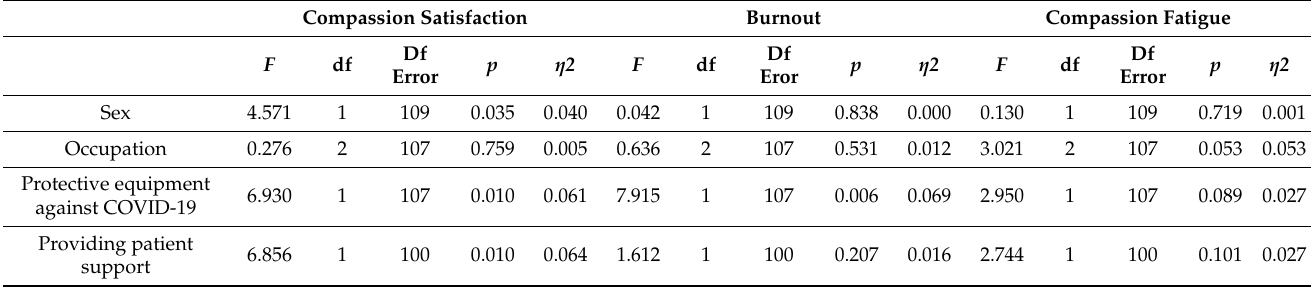
Table 3. Follow-up ANOVAs exploring differences in professional quality of